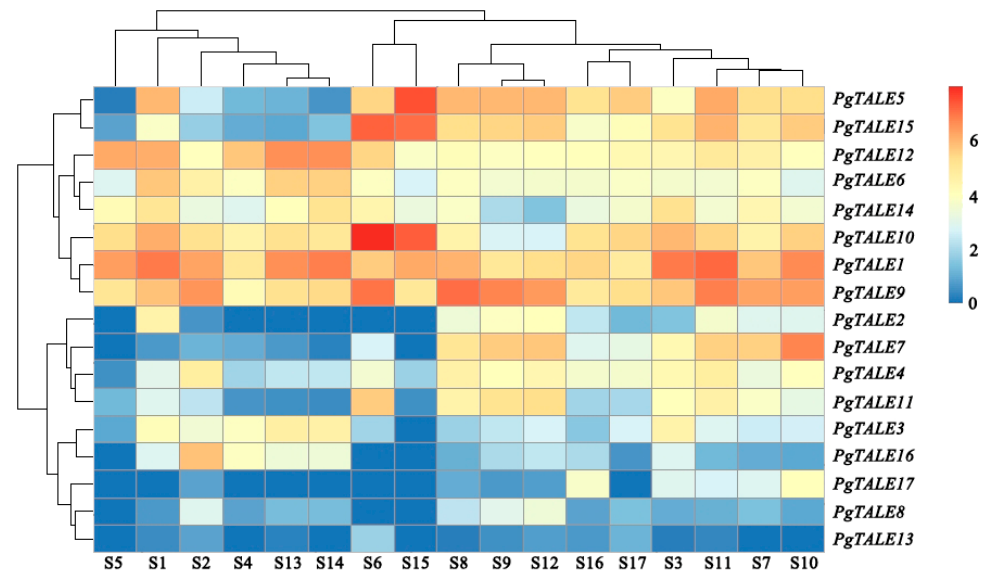
Figure 6. Heatmap of PgTALE gene expression in different tissues. Note: S1: Root; S2: Flesh leaf; S3: Flower; S4: Inner seed coat of ‘Dabenzi’ (50 days after pollination); S5: Outer seed coat (50 days after